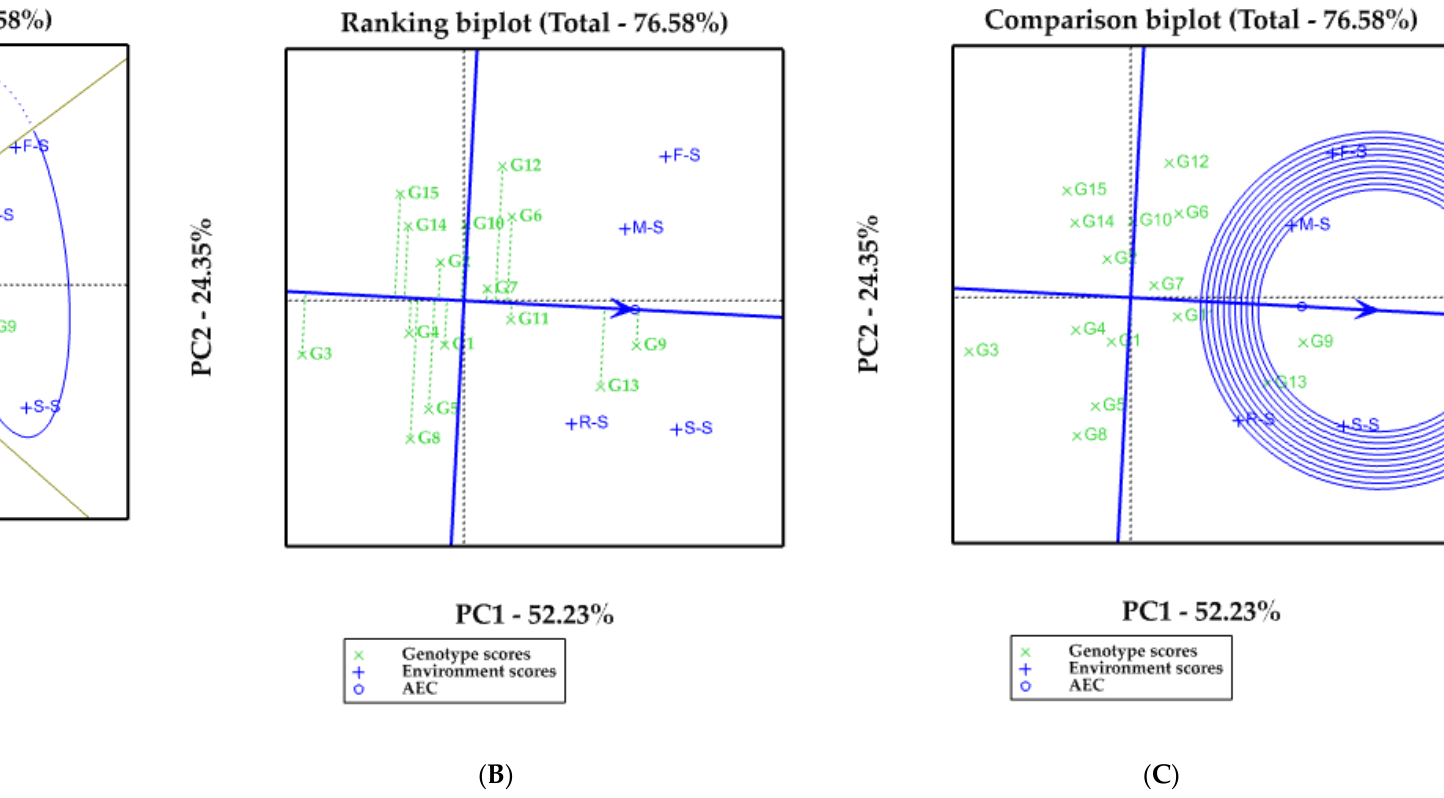
Figure 2. Soybean crop rotation stability in the dry season. ( A ) GGE biplot polygon with which-won-where pattern; ( B ) AEC shows the GGE biplot based on environmental scaling of the mean value and stability of genotype; ( C ) GGE biplot based on genotype-focused scaling to compare genotypes with the ideal genotype. G1: Anjasmoro; G2: Argomulyo; G3: Baluran; G4: Biosoy I; G5: Burangrang; G6: Dega I; G7: Dena I; G8: Dena II; G9: Dering I; G10: Dering II; G11: Dering III; G12: Devon I; G13: Grobogan; G14: Mahameru; G15: Tanggamus. F–S: Soybean planting after fallow; R–M: Soybean planting after maize; R–S: Soybean planting after rice; S–S: continuous soybean.